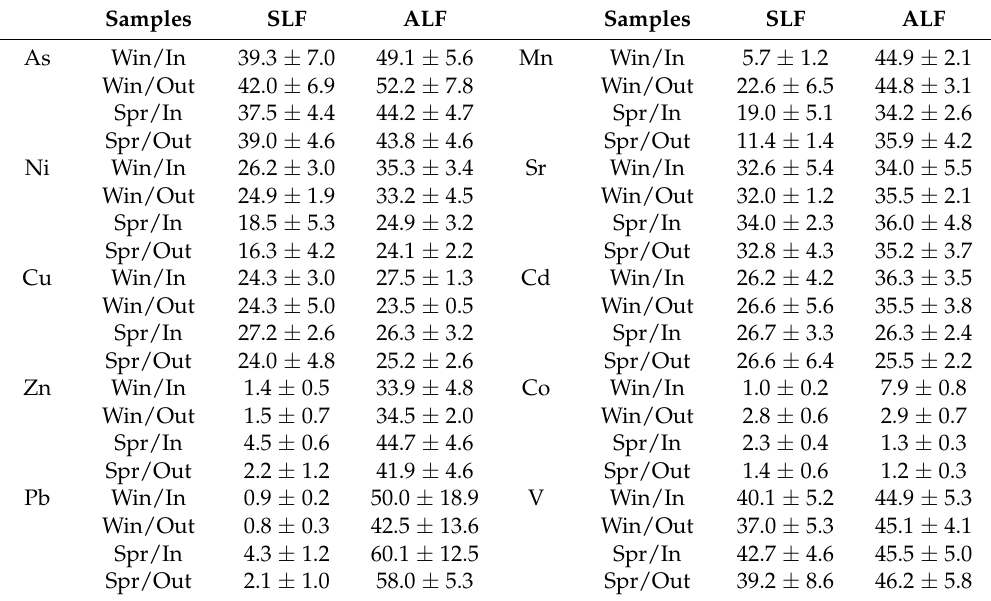
Table 3. In vitro bioaccessibility (%) of toxic elements in the indoor/outdoor <3.3 µ m fractions in winter and spring extracted by SLF and ALF ( n =